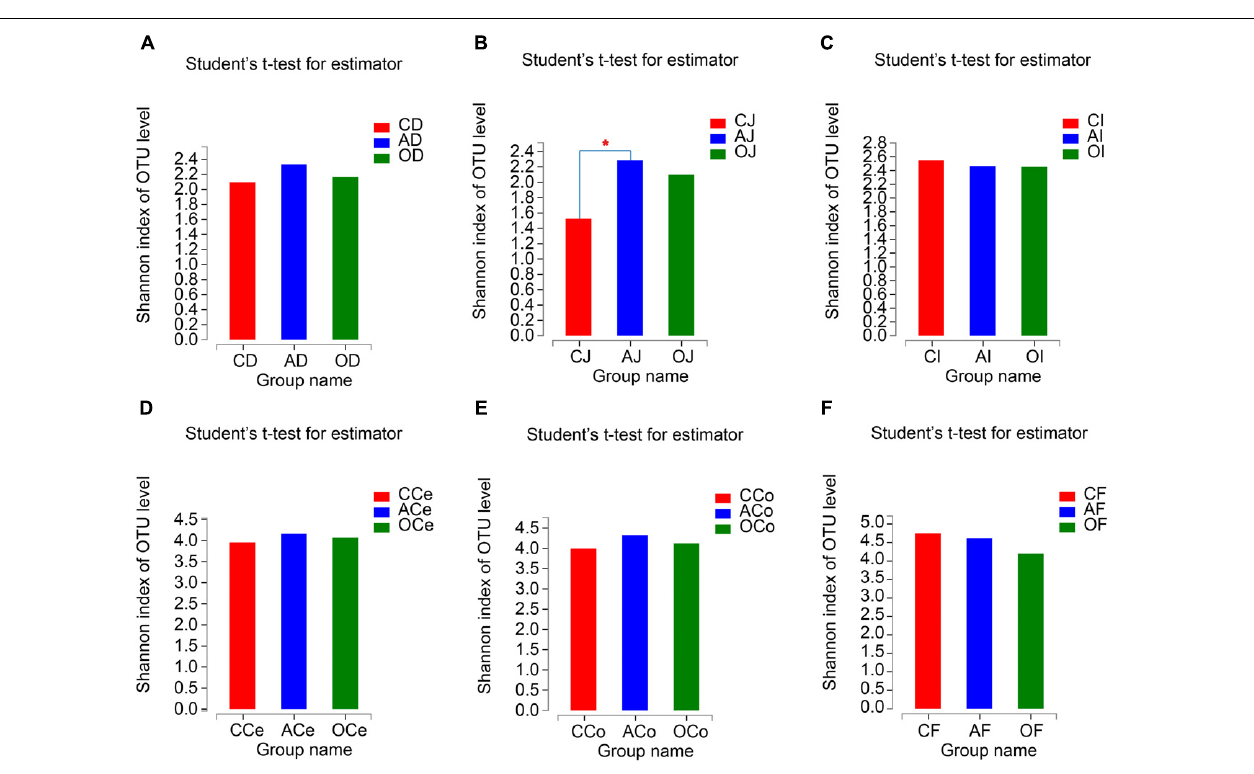
FIGURE 2 | The Shannon Diversity Index Analyses of Microbiota Community. (A) Duodenum samples. (B) Jejunum samples. (C) Ileum samples. (D) Cecum samples. (E) Colon samples. (F) Feces samples. CD, AD, and OD: duodenum mucosal microbiota of control group, alfalfa meal group and commodity concentrated fiber group, respectively. CJ, AJ, and OJ: jejunum mucosal microbiota of control group, alfalfa meal group and commodity concentrated fiber group, respectively. CI, AI, and OI: ileum mucosal microbiota of control group, alfalfa meal group and commodity concentrated fiber group, respectively. CCe, ACe, and OCe: cecum mucosal microbiota of control group, alfalfa meal group and commodity concentrated fiber group, respectively. CCo, ACo, and OCo: colon mucosal microbiota of control group, alfalfa meal group and commodity concentrated fiber group, respectively. CF, AF, and OF: feces mucosal microbiota of control group, alfalfa meal group and commodity concentrated fiber group, respectively. ∗ 0.01 < P < = 0.05, ∗∗ 0.001 < P < = 0.01, ∗∗∗ P < =